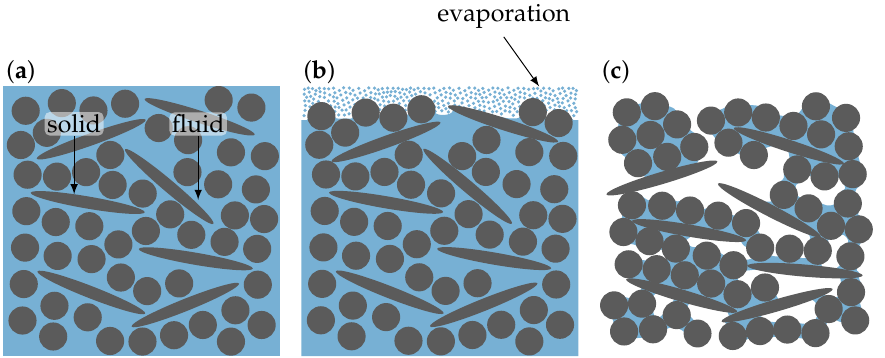
Figure 2. Illustration of the drying cell strategy. ( a ) shows the particle configuration in the wet filament as produced by the printing process. During the first stage of drying ( b , c ), most of the water evaporates and the particles change their